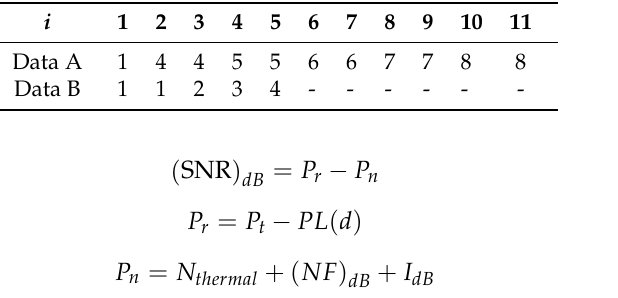
Table 4. Preset number of data copies in Weldon’s ARQ n i .